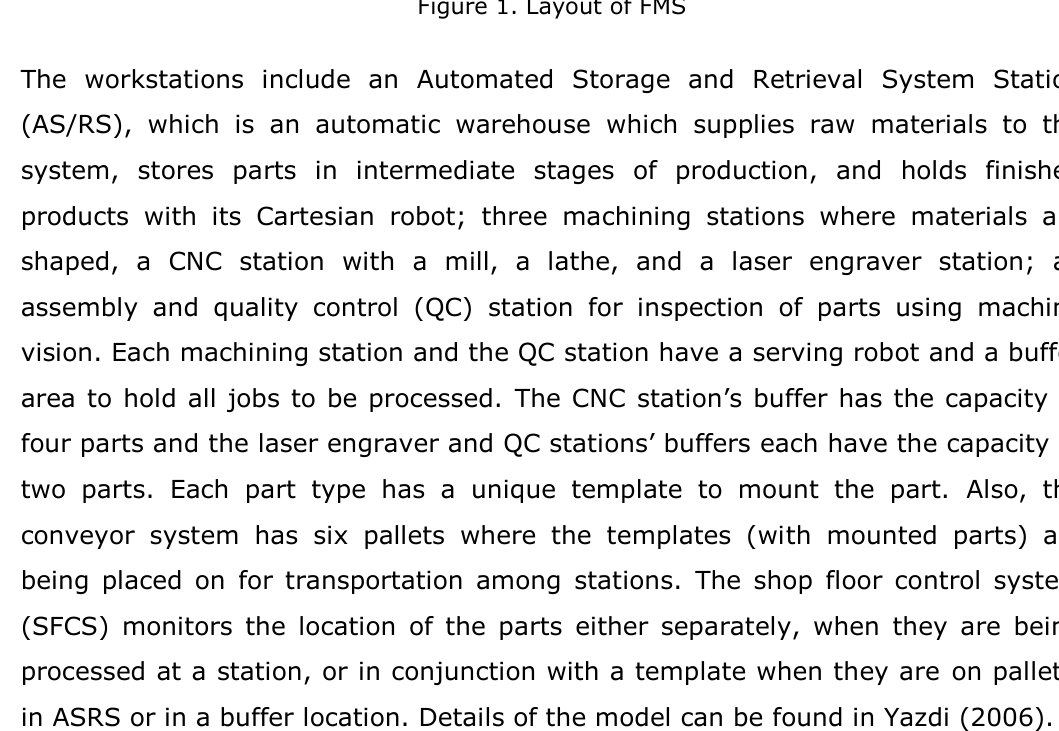
Figure 1. Layout of